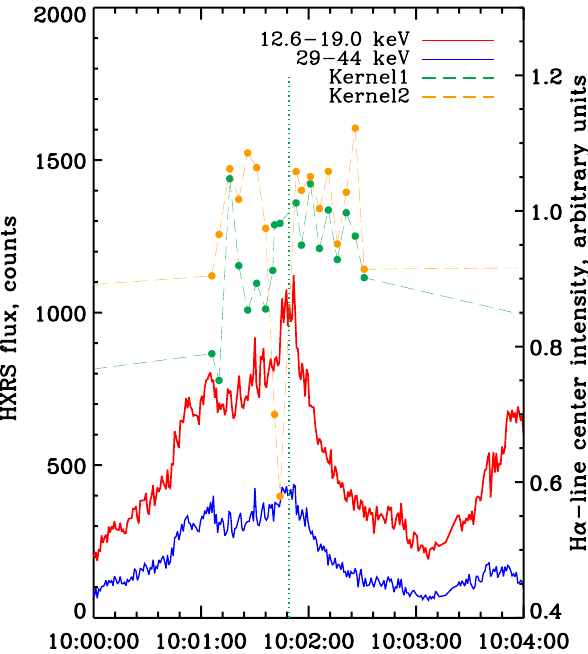
Fig. 9. Temporal evolution of HXR obtained by HXRS and the H α - line center intensity of the kernels. The dash-dotted vertical green line shows the moment of missing MFS